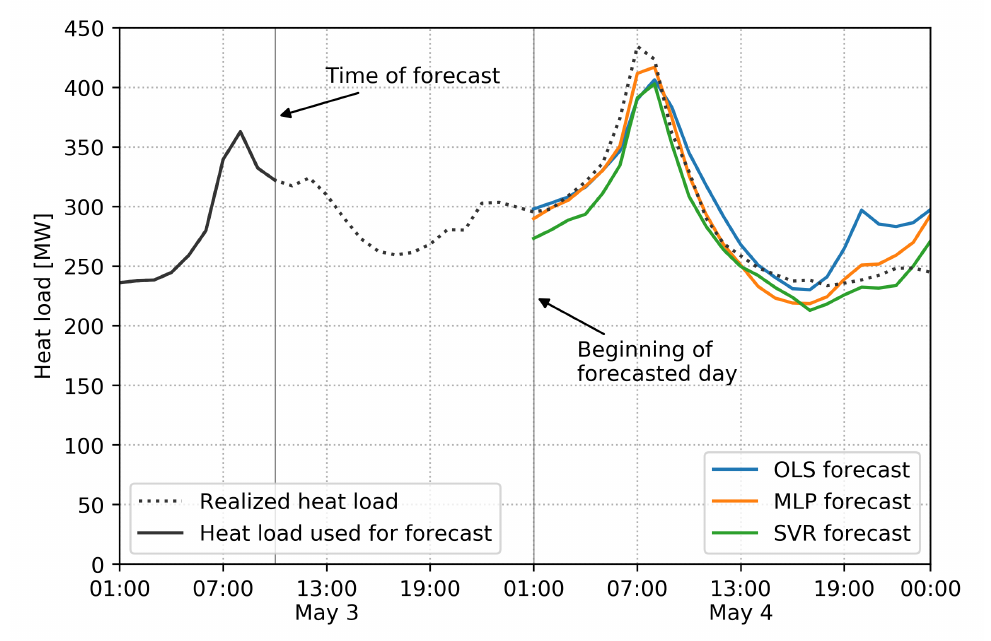
Figure 3. Example forecasts for 4 May 2016. The forecasts were produced on 3 May at 10:00 and based on real weather forecasts, calendar, and holiday